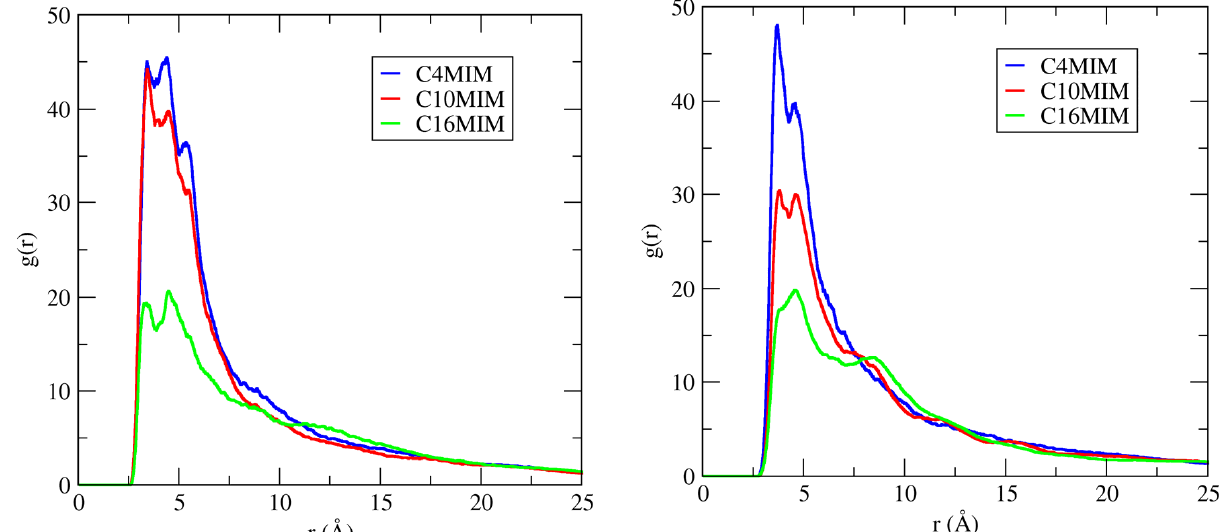
Figure 11. RDFs of the center-of-mass around minor grooves of DNA duplex in 20 mM IL solutions. The electronegative sites N3 and O2 atoms for the minor groove were used for these RDF calculations. ( Left panel ): Data for the imidazolium ring–groove interactions. ( Right panel ): Data for tail–groove interactions.